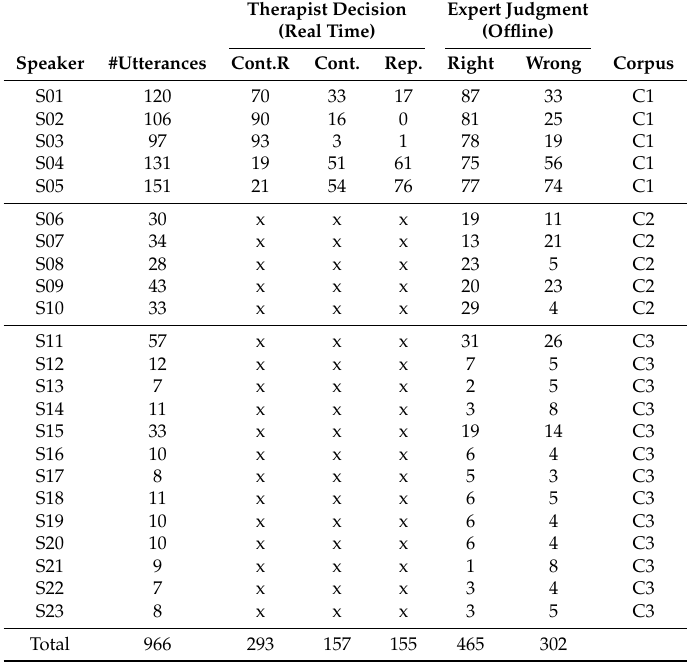
Table 1. Corpus description. Concerning the therapist decision, Cont.R (Continue Right) means that the activity was rightly resolved, Cont (Continue) means that the activity was resolved but the response could be better and Rep. (Repeat) means that the activity was faultily resolved. Concerning the expert judgment, Right means that the recording was rightly produced and Wrong means that the recording was wrongly produced.